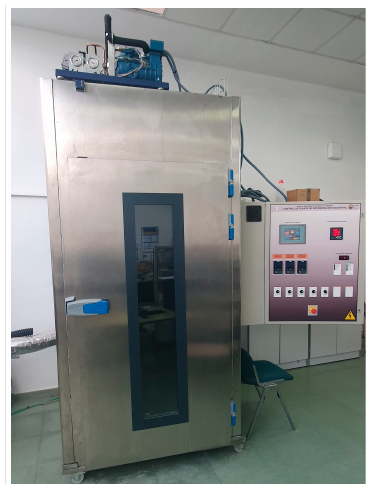
Figure 2. Refrigerating